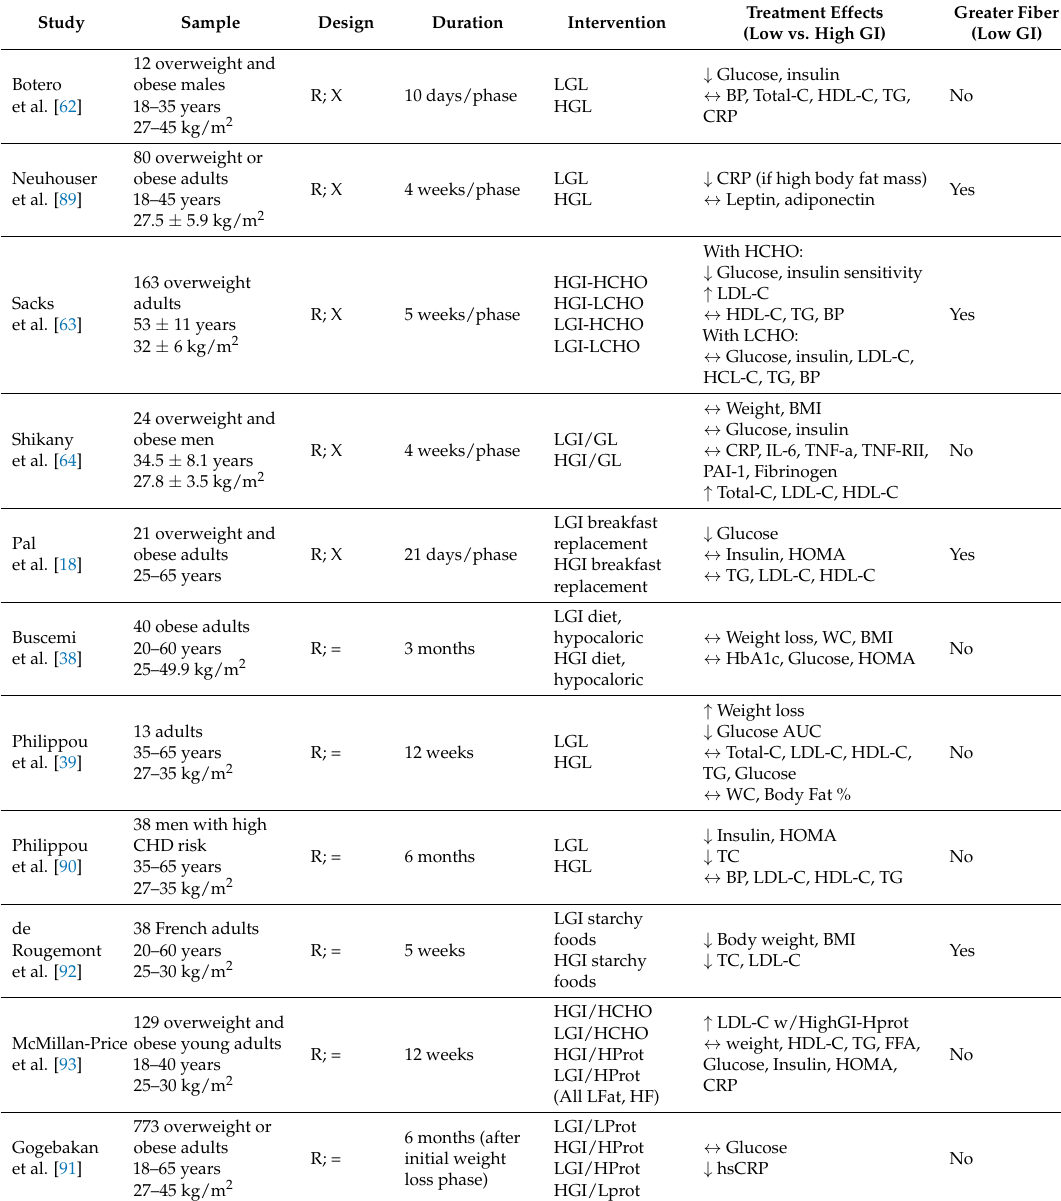
Table 10. Intervention studies assessing the effects of diets with different GI on cardiovascular disease risk factors 1 .